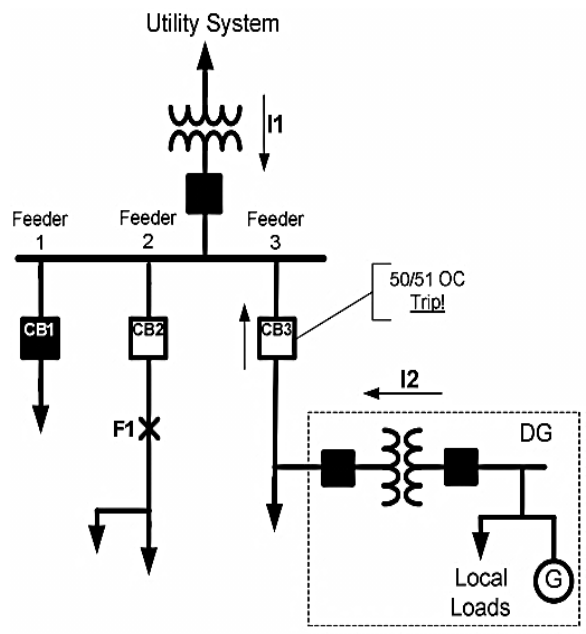
Figure 4. Example of false tripping effect on NDOCR of CB3 due to a fault at the adjacent feeder No. 2.